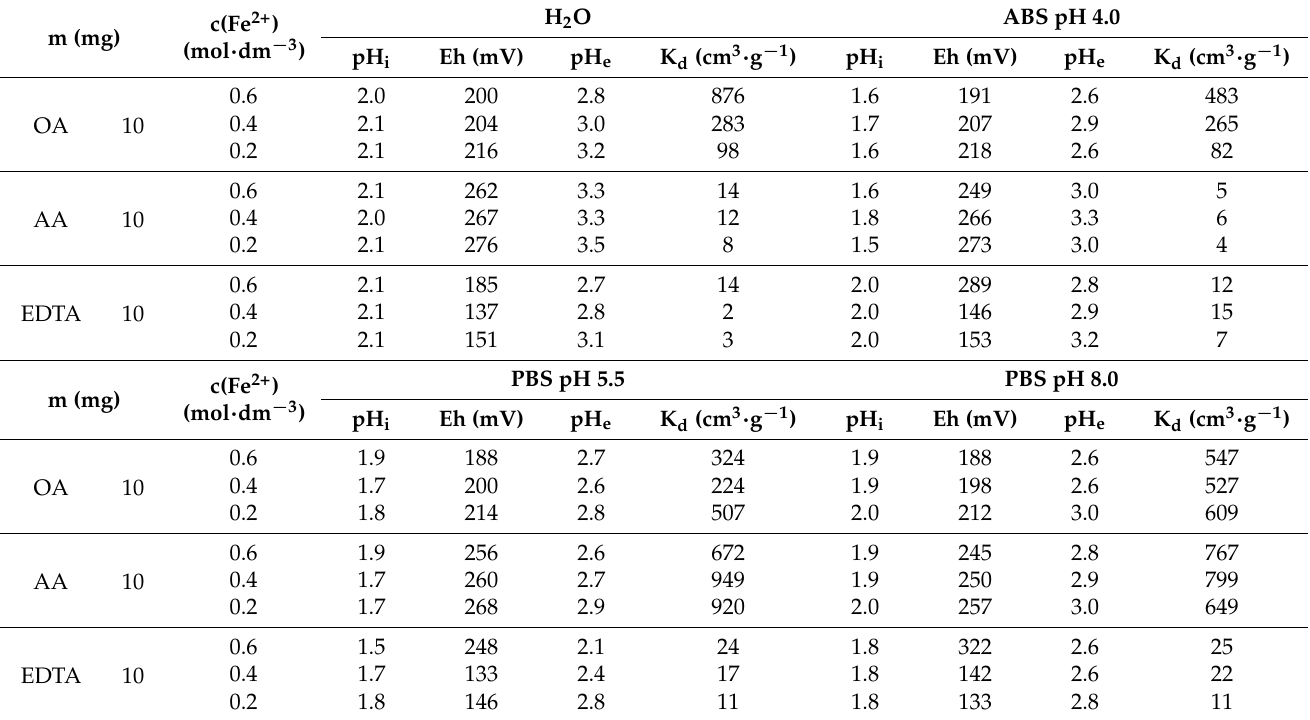
Table 2. Parameters of technetium sorption on hydroxyapatite in a reducing environment in the presence of FeSO 4